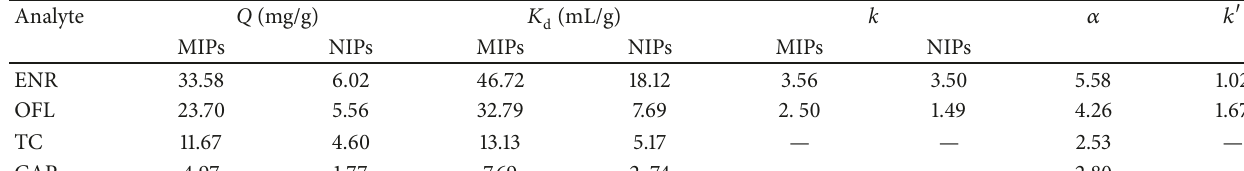
Table 4: The selective coefficient of the P GMA